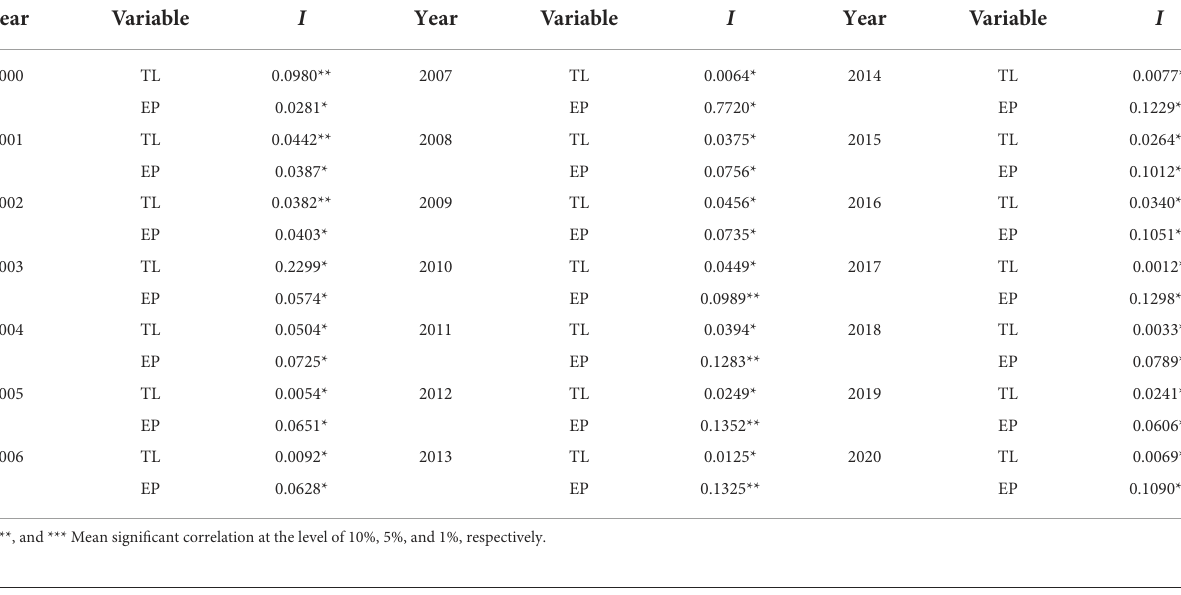
TABLE 3 Global Moran’s I index of each core variable from 2000 to 2020.